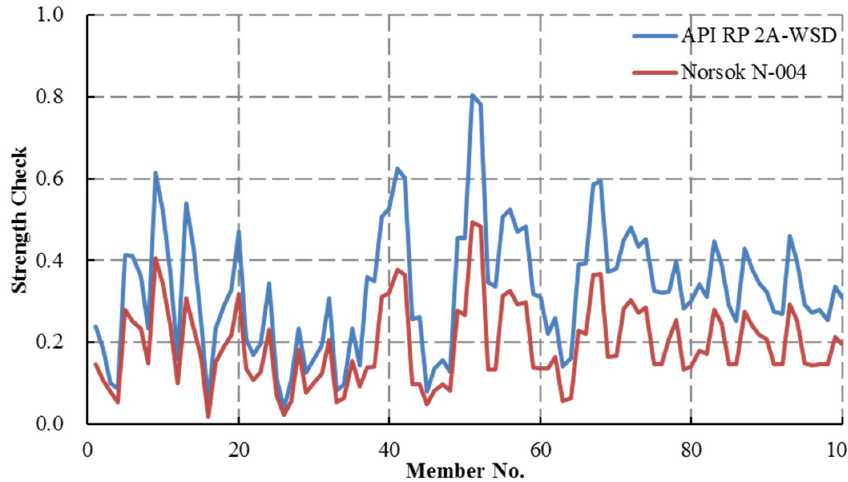
Figure 24. Member Strength Check (Case 6).